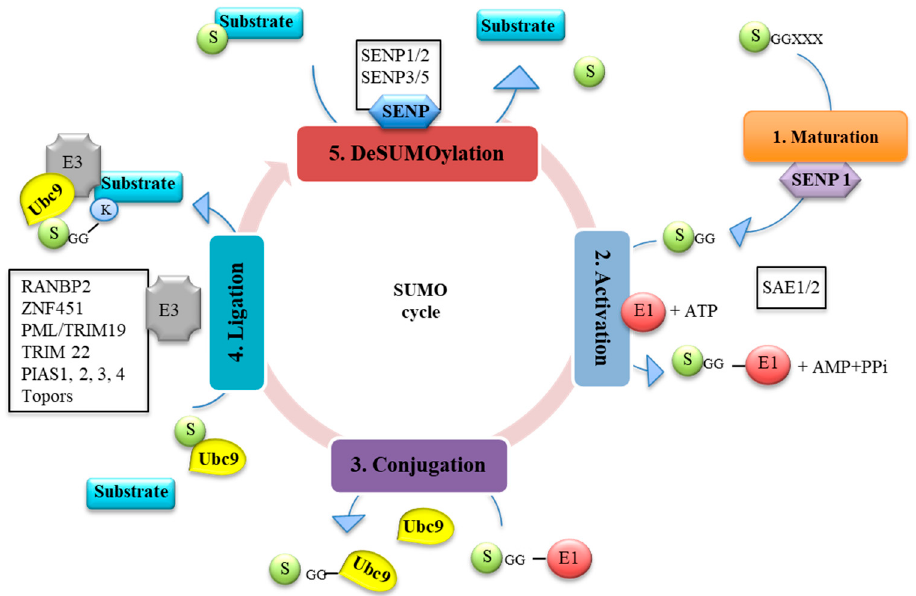
Figure 1. The SUMO cycle. SUMOylation is processed in five major steps: 1. Maturation: The immature form of SUMO is processed by specific proteases (SENPs) (to expose its C terminal diglycine (GG) motif (X: any amino acid). 2. Activation: in an ATP consuming reaction, the E1 activating enzyme (SAE1/2) activates the matured SUMO to form a high energy thioester bond. 3. Conjugation: SUMO is then transferred to the E2 conjugating enzyme (Ubc9) and form a thioester bond. 4. Ligation: SUMO is conjugated to its substrate with the help of an E3 ligase and 5. DeSUMOylation: SUMO can be removed from its target substrate by SENPs and engage in a new cycle.